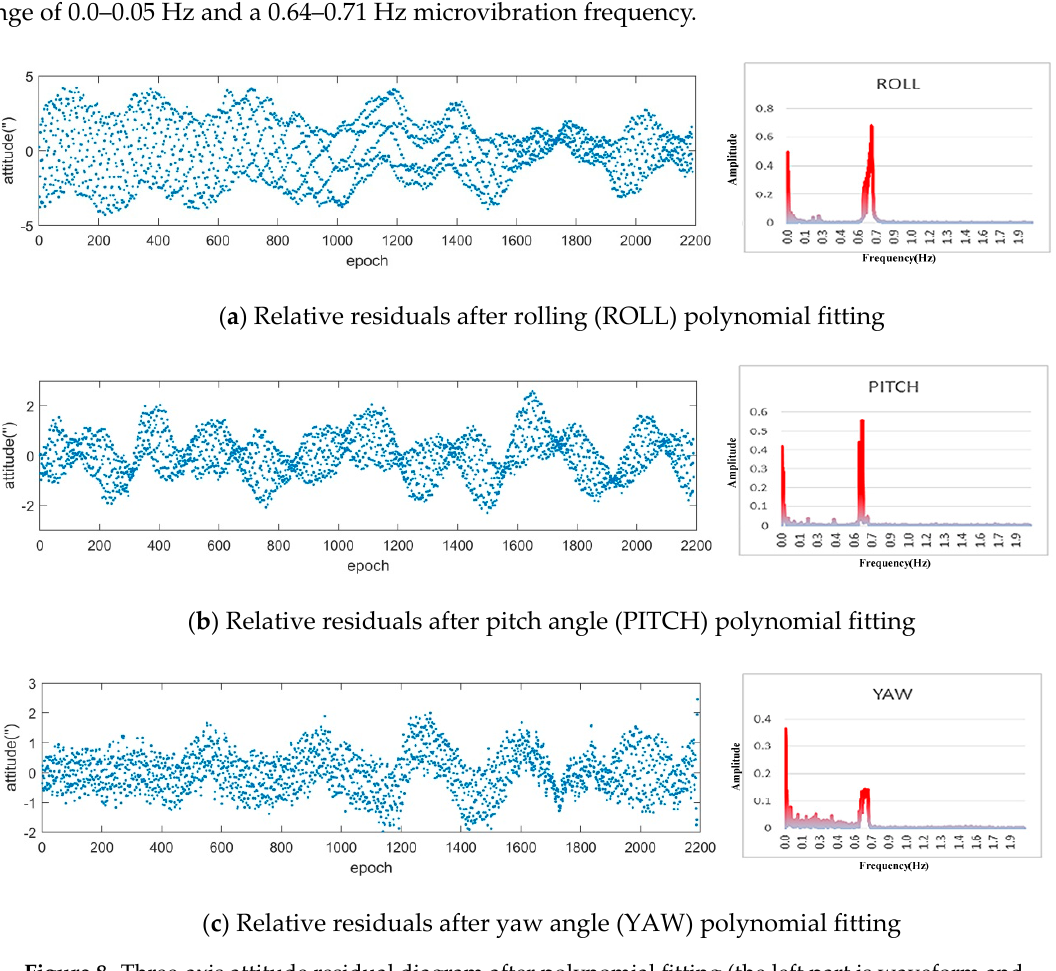
Figure 8. Three-axis attitude residual diagram after polynomial fitting (the left part is waveform and the right part is frequency).